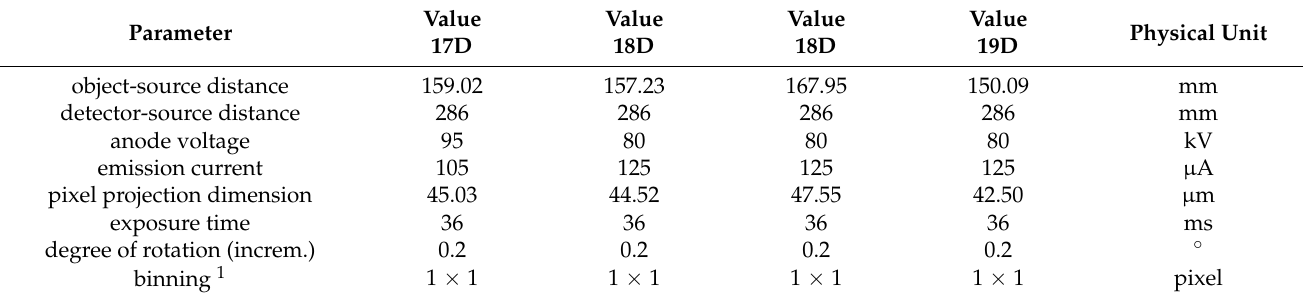
Table A16. Values of set parameters on SkyScan 1275.